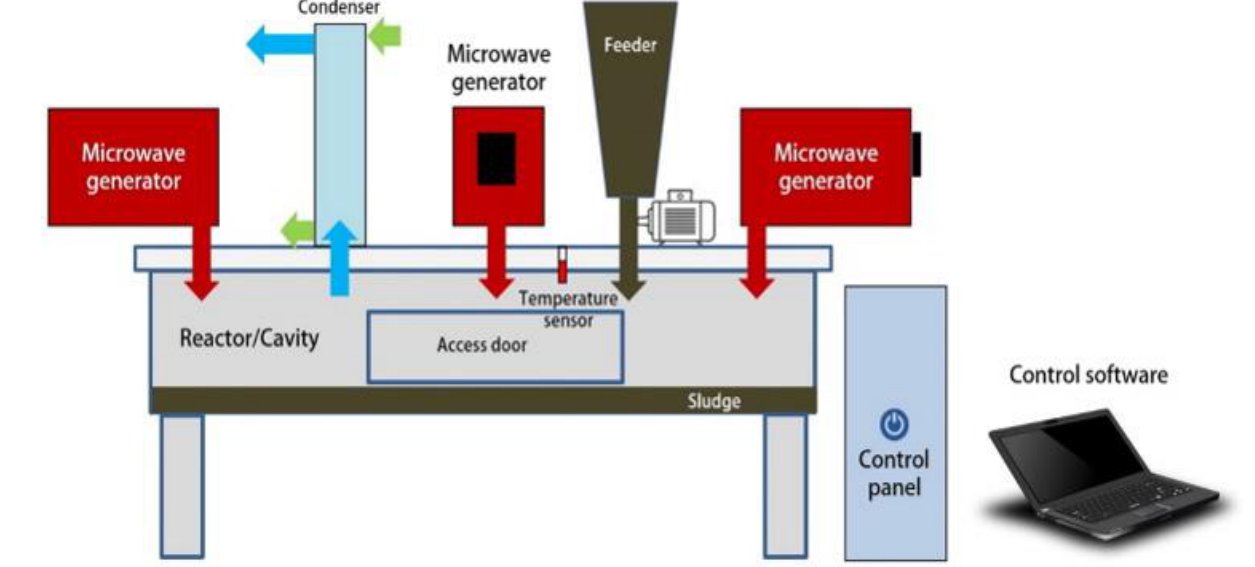
Figure 11. Schematic representation of pilot plant-scale MW reactor for the treatment of sludge from BW. This figure was reused from the work of Peter M. Mawioo et al. Reprintedunder the Creative Commons license (CC by 4.0) [63] .